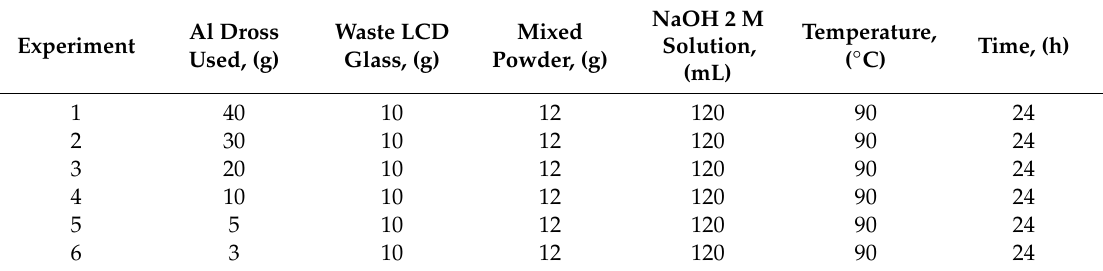
Table 1. Experimental conditions employed for zeolite